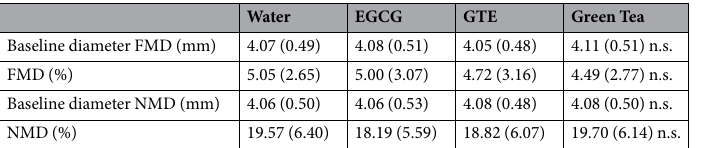
Table 3. Baseline diameter and baseline FMD and NMD before interventions. FMD, flow-mediated dilation; NMD, nitro-mediated dilation; GTE, green tea extract; baseline diameter, diameter of artery brachialis before hyperaemic stimulus or application of nitroglycerine. n.s.; no significant differences by repeated measures ANOVA. Values are mean (SD) from n = 50 subjects.